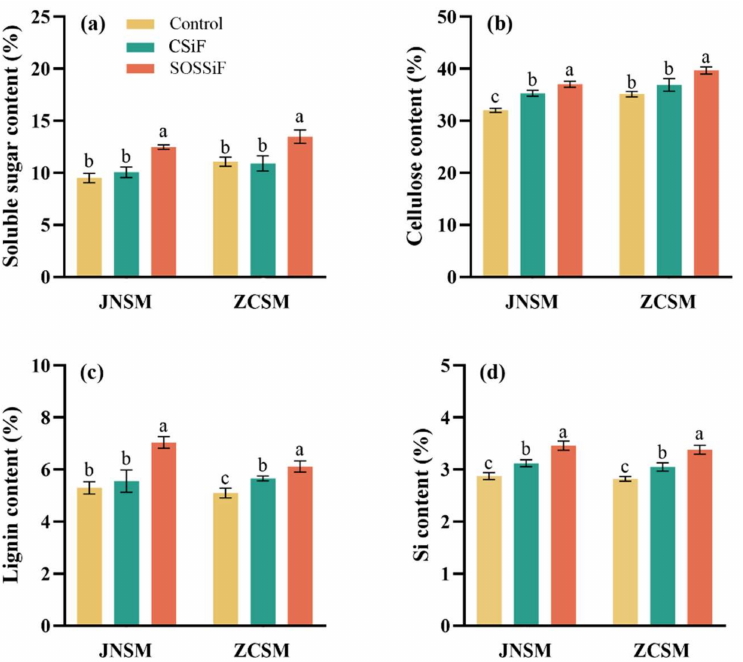
Figure 8. Effect of different Si treatments on the contents of culm chemical components. ( a ) soluble sugar, ( b ) cellulose, ( c ) lignin, ( d ) silicon. Different small letters above the histogram of the same rice variety indicated significant